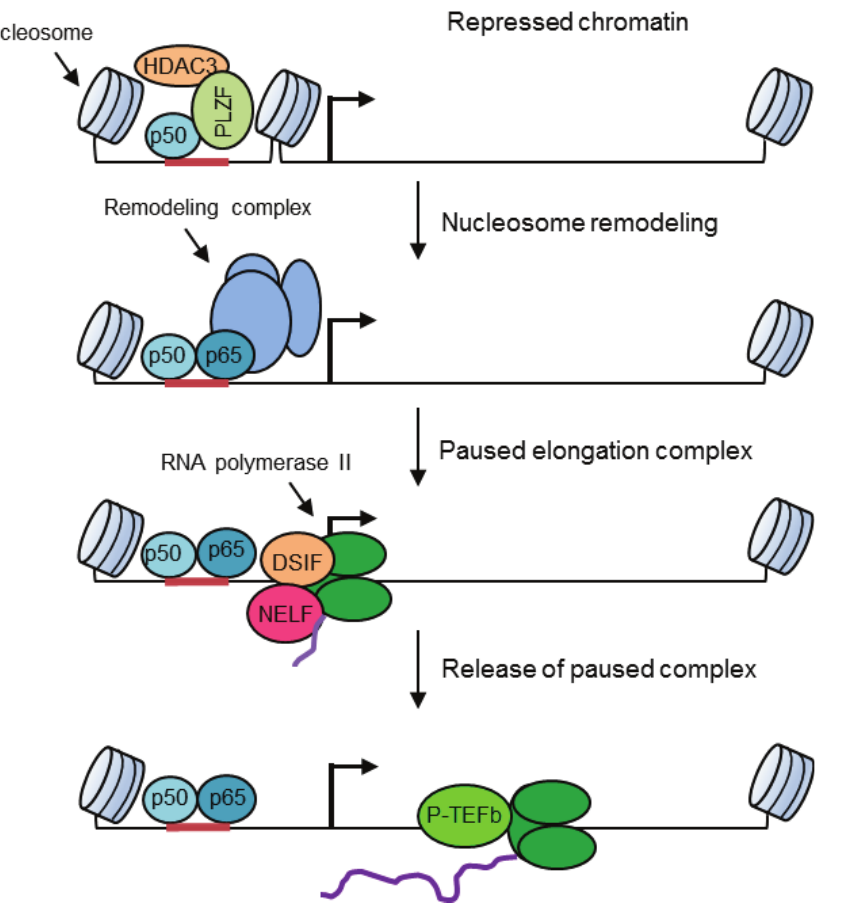
Figure 5. A schematic diagram showing a repressed chromatin state, nucleosome